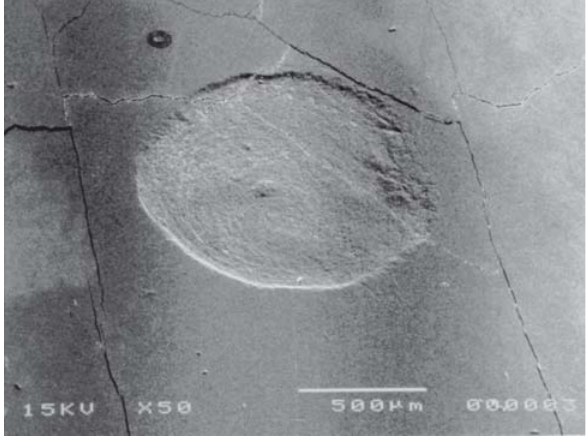
FIGURE 5- Scanning electron microscopy of demineralized enamel after prophylaxis with pumice slurry- Group III (Original magnification, X